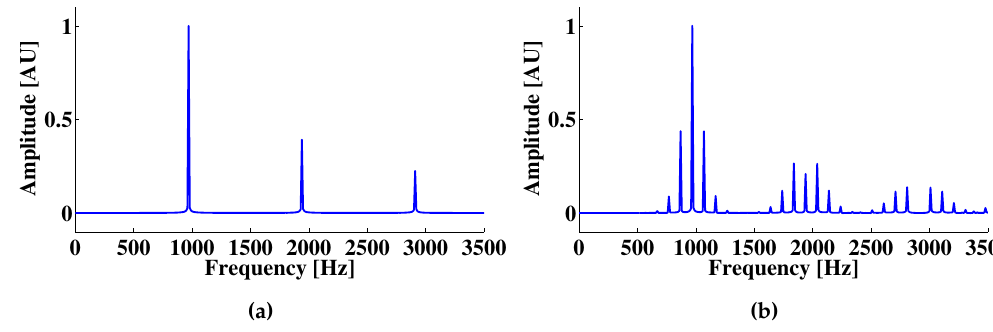
Figure 8. ( a ) Frequency spectra of a simulated mechanically-modulated OFI sensor signal without target motion; ( b ) The effect of the cantilever motion over the frequency spectra; different peaks are observed around the main OFI frequency and its corresponding harmonics; the frequency difference between the main OFI peak and the highest amplitude peak around it is equal to the target vibration